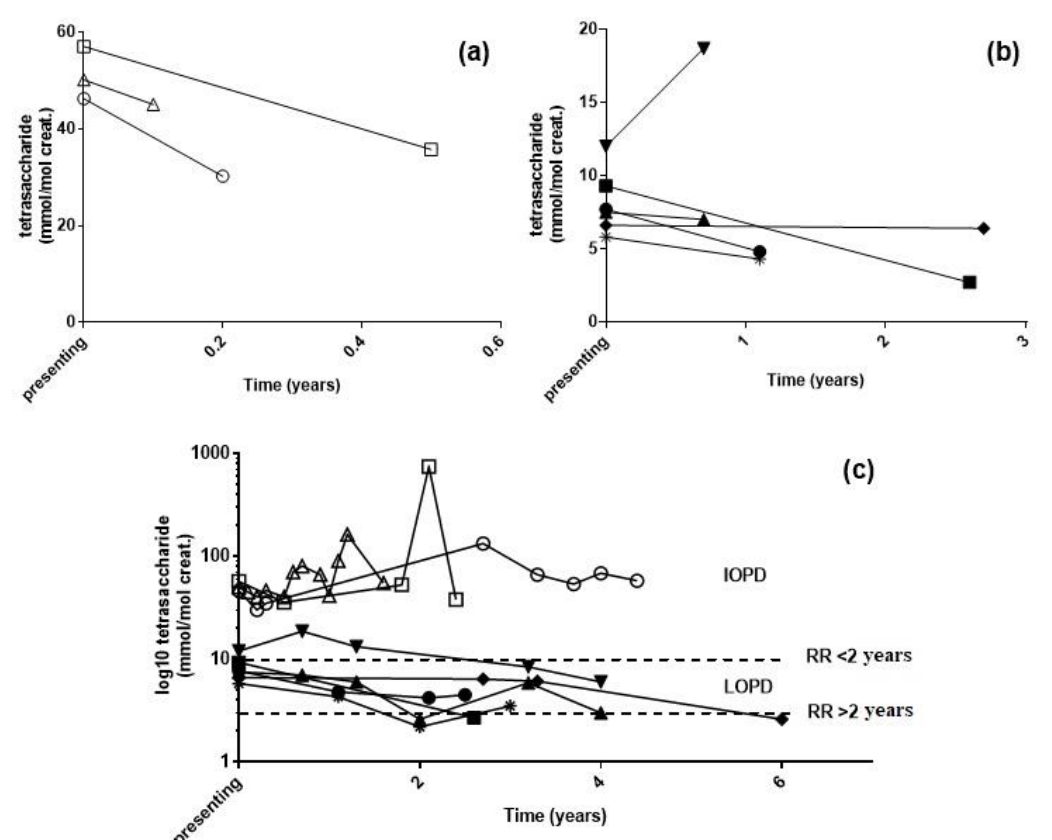
Figure 4. Urine tetrasaccharide concentrations following enzyme replacement therapy: ( a ) IOPD and ( b ) LOPD patients at diagnosis and first urine post-treatment. ( c ) Long-term monitoring of patients following treatment. RR, reference range. c.953T>C homozygous, 0.6 years at diagnosis; c.323G>A homozygous, 0.9 years at diagnosis; c.266G>T/c.2815_2816del, 0.7 years at diagnosis;